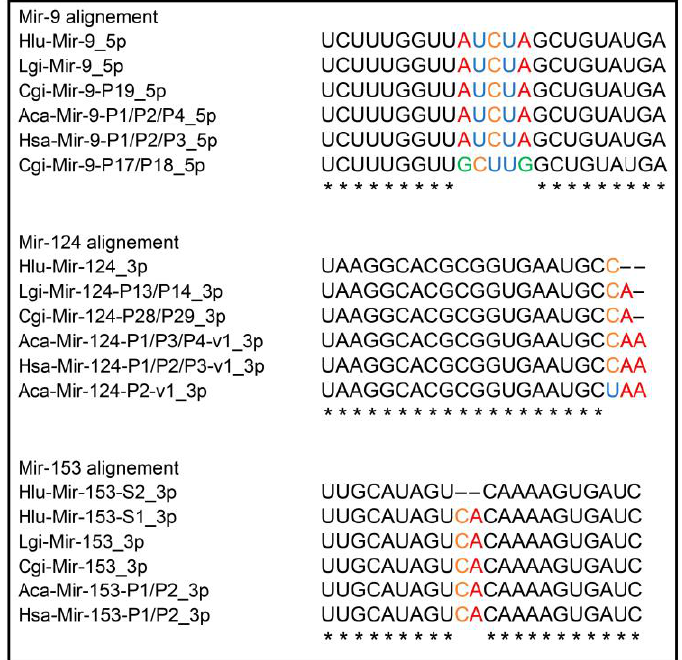
Figure 3. Alignment of human’s and mollusks’ mature miRNA sequences belonging to the families MIR-9, MIR-124, and MIR-153. Differences in the sequences are highlighted by color. Species designations: Hsa- H. sapiens , Hlu- H. lucorum , Lgi- L. gigantea , Cgi- C. gigas , Aca- A. californica . For some other miRNAs, comparative analysis data are presented in Supplementary File S3. * indicates top conserve nucleotides.